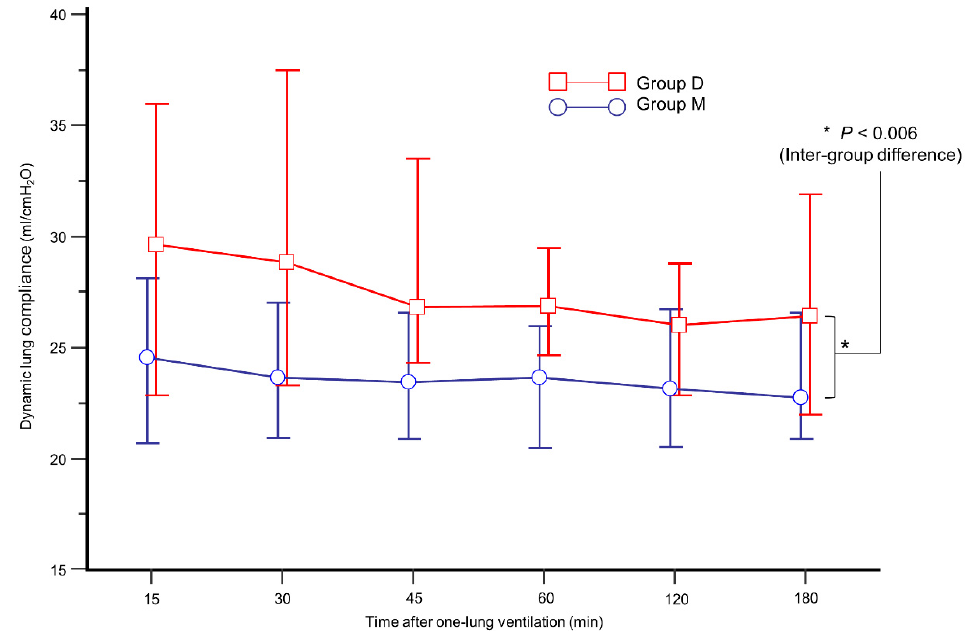
Figure 3. Comparison of mean dynamic lung compliance during one-lung ventilation between group M (blue circle) and group D (red box).